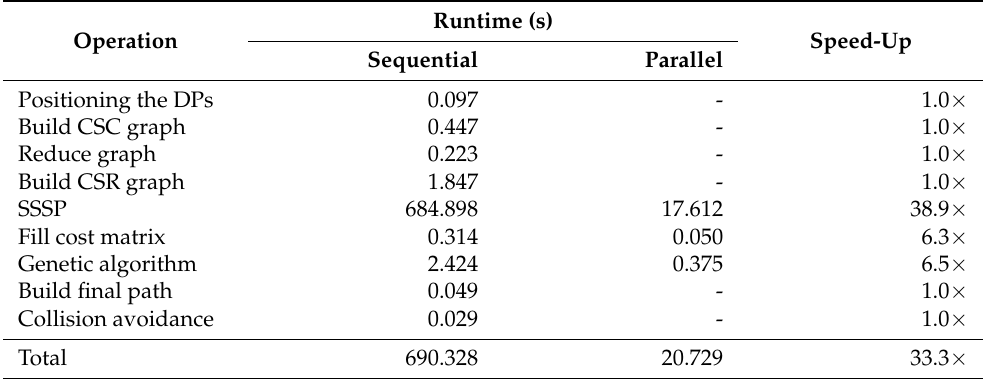
Table 4. Runtime and Speed-up for the Proposed Wireless Sensor Data Acquisition Algorithm (3 UAVs, 55POIs, and resolution of 500 × 294 ×